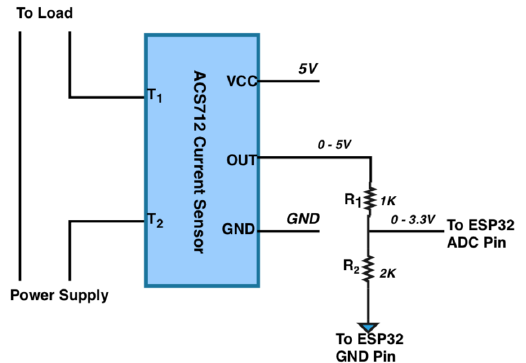
Figure 3. ACS712 step-down resistors